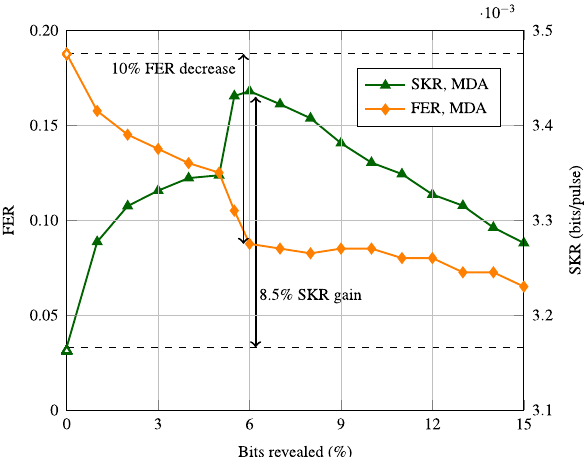
Figure 3. FER and SKR of MDA with n = 2 . The rate R c of the first code is 0.02. The rate of the second code used depends on the amount of bits revealed, where zero bits revealed (white markers) is equivalent to the conventional protocol. The simulations were performed at SNR = − 15.23 dB.